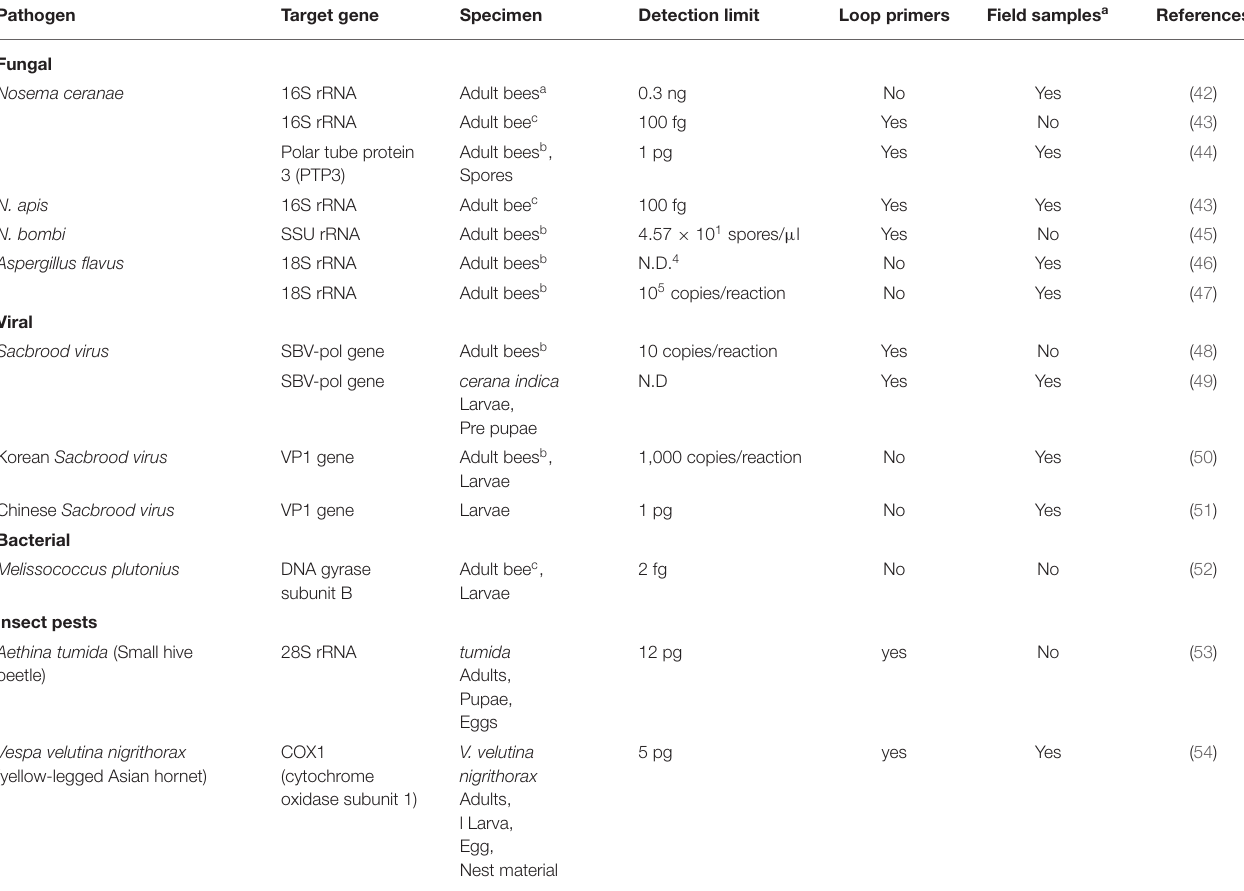
TABLE 1 | LAMP assays developed for the detection of pathogens and pests of honey bees.